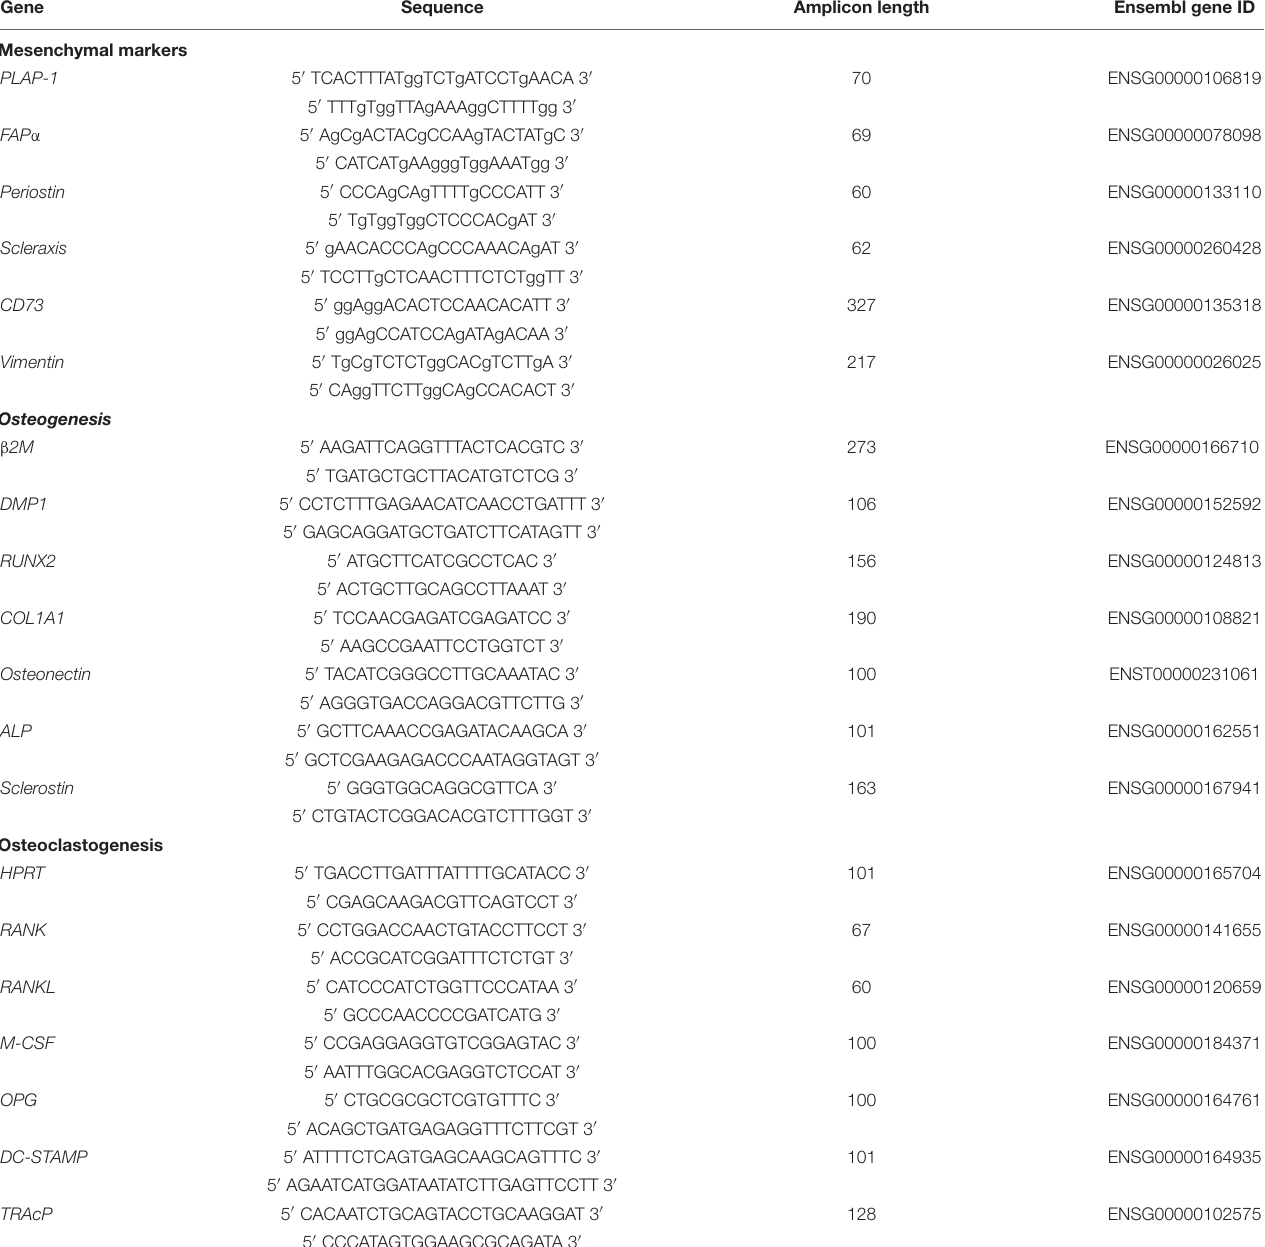
TABLE 1 | Primer sequences used for quantitative polymerase chain reaction